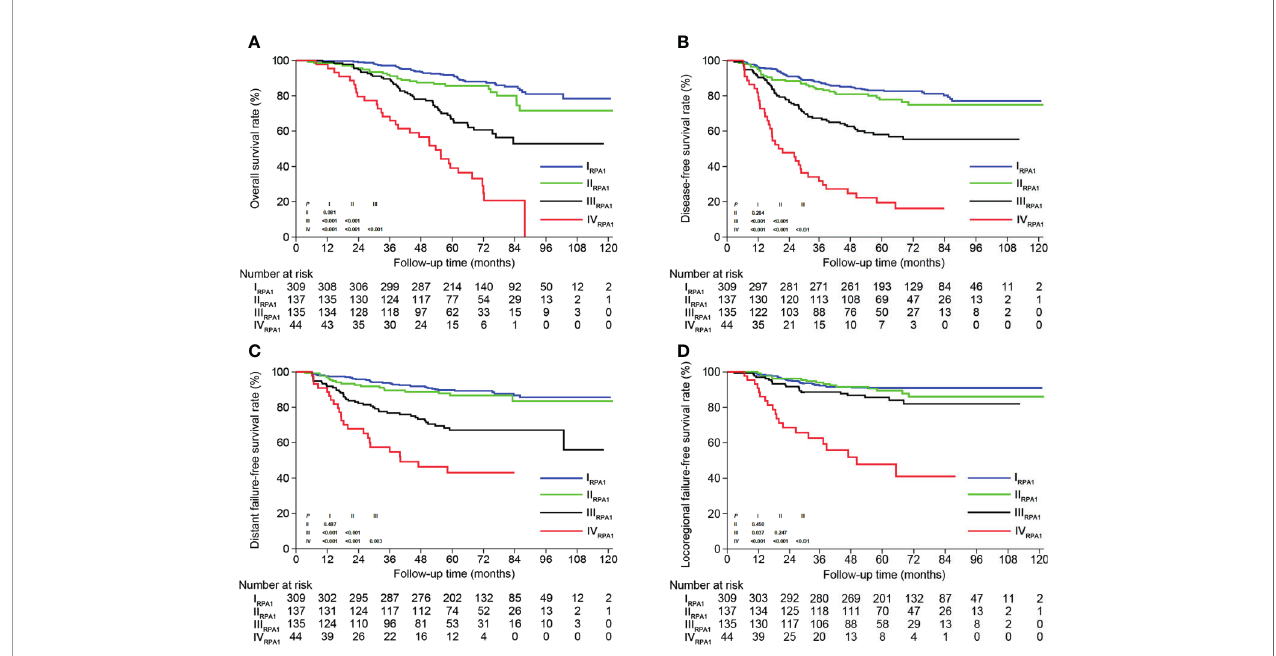
FIGURE 4 | Kaplan-Meier survival curves of (A) overall survival, (B) disease-free survival, (C) distant failure-free survival and (D) locoregional failure-free survival between different risk groups of RPA1 staging.